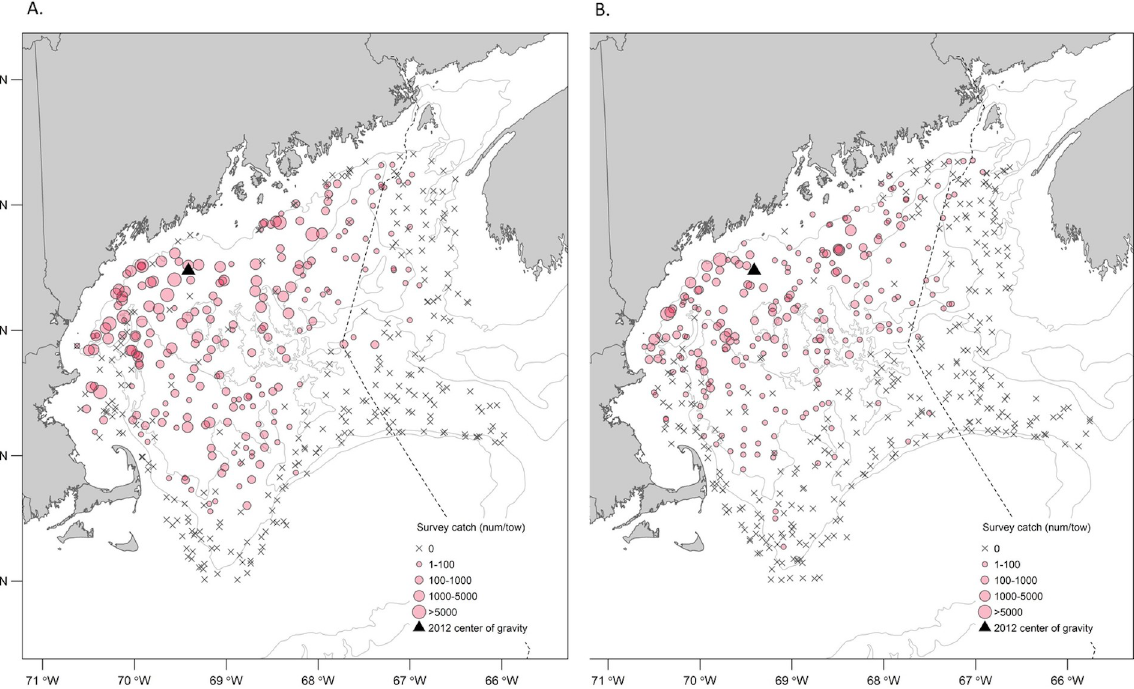
PLOS ONE | https://doi.org/10.1371/journal.pone.0253914 July 21,